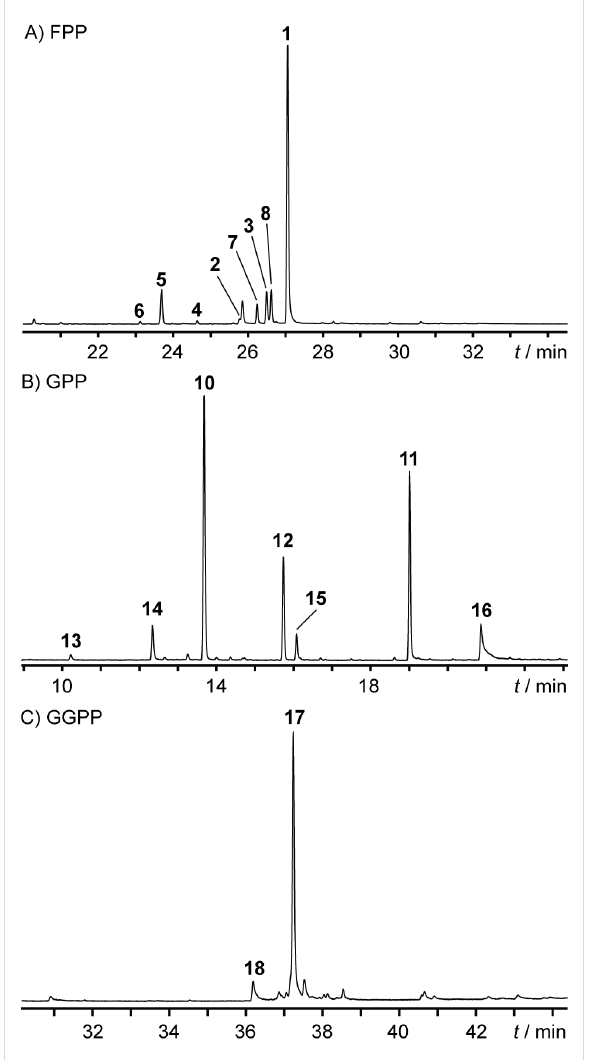
Figure 1: Total ion chromatograms of hexane extracts from the incu- bations of HcS with A) FPP, B) GPP and C) GGPP. Peak numbering refers to the compounds shown in Figure 2 and listed in Table